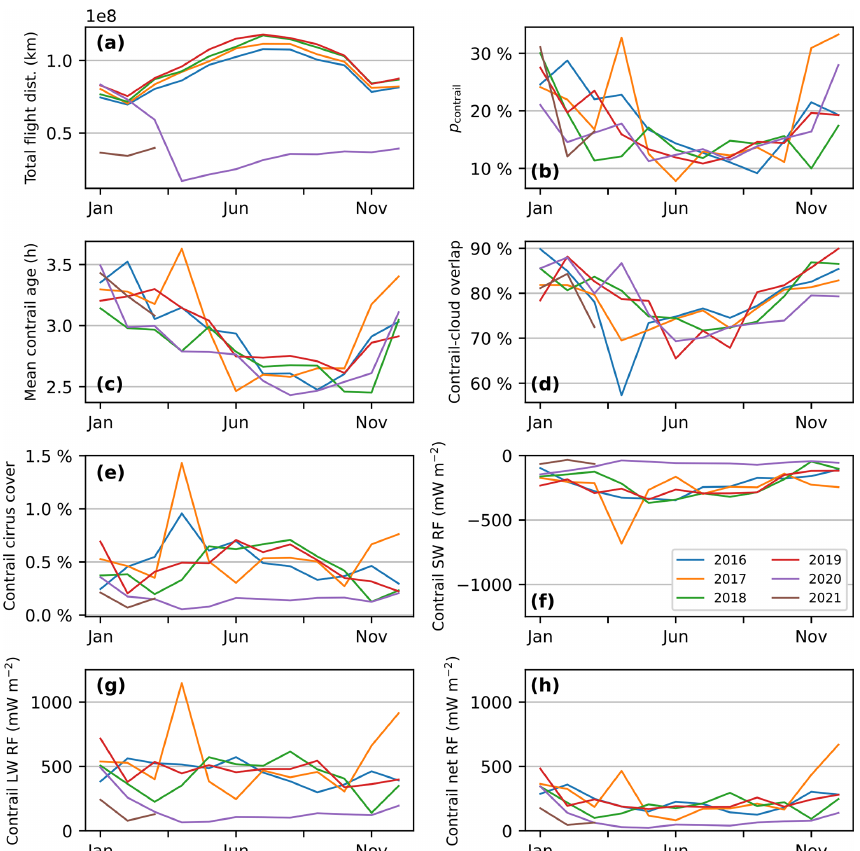
Figure 1. Monthly statistics in the North Atlantic region from January 2016 to March 2021, including the (a) total flight distance; (b) per- centage of the flight distance forming persistent contrails (p contrail ); (c) mean contrail age; (d) percentage of the contrail area overlapping with natural cirrus; (e) contrail cirrus cover; and (f) contrail cirrus SW RF, (g) LW RF and (h) net RF. Additional variables that are not presented in this figure are available in Fig. S14 (Sect.